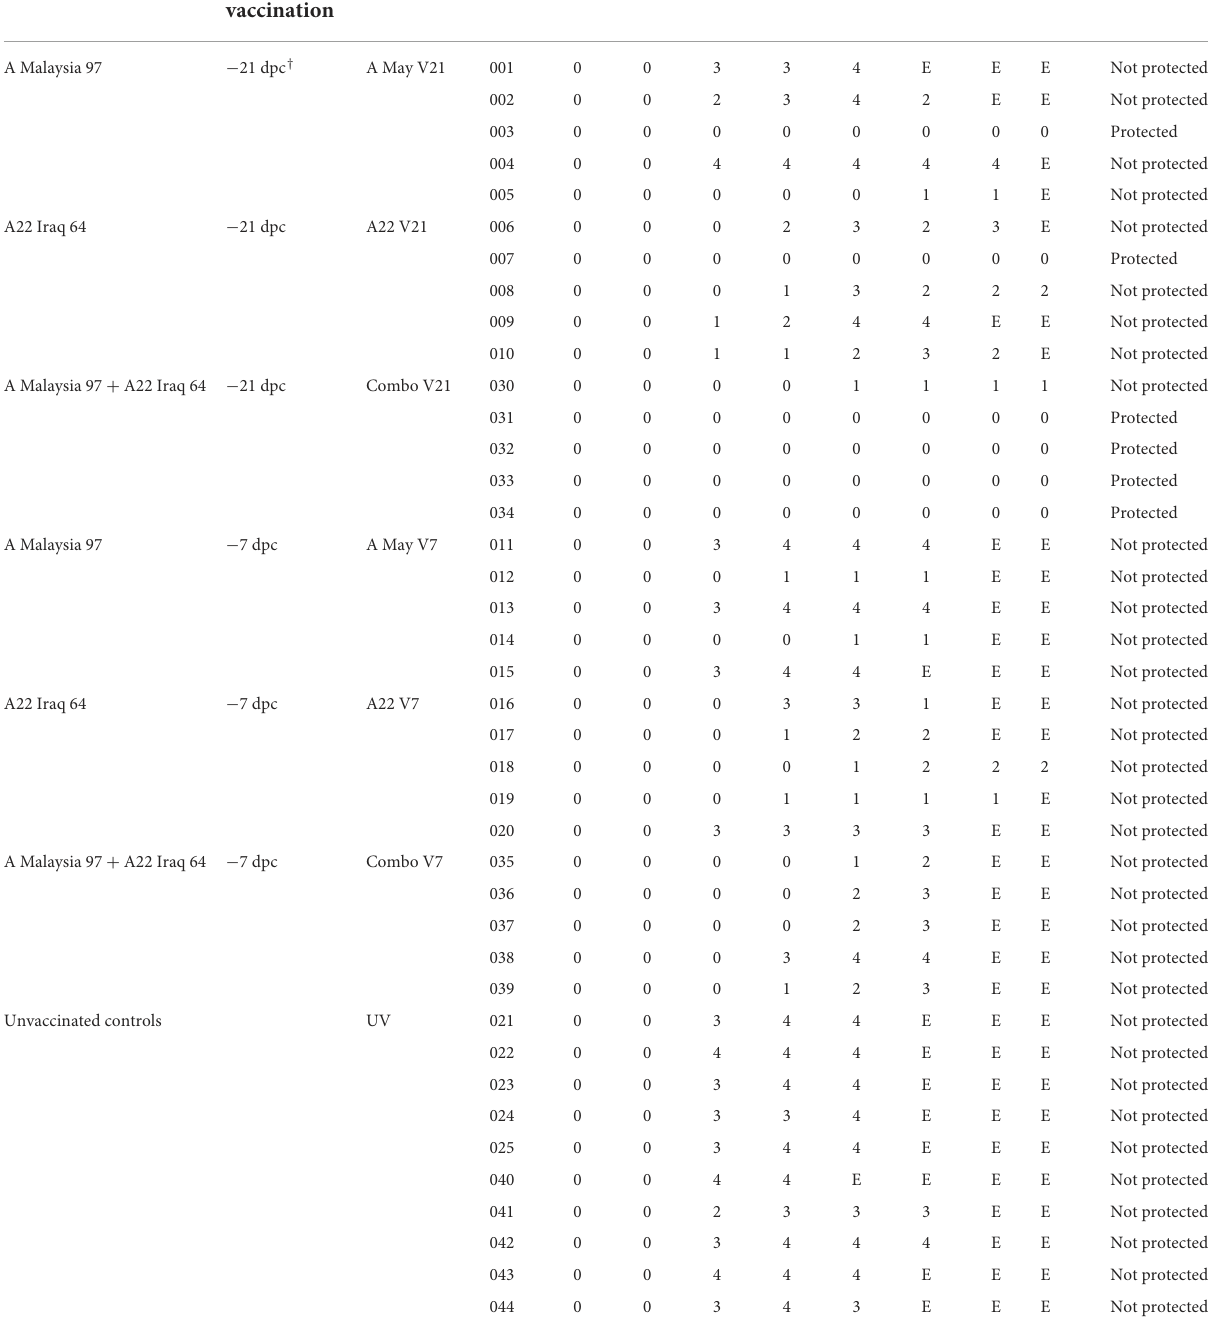
TABLE 1 The individual lesion scores for the first 7 dpc and the time of euthanasia as well as the protection outcome. Vaccine Day